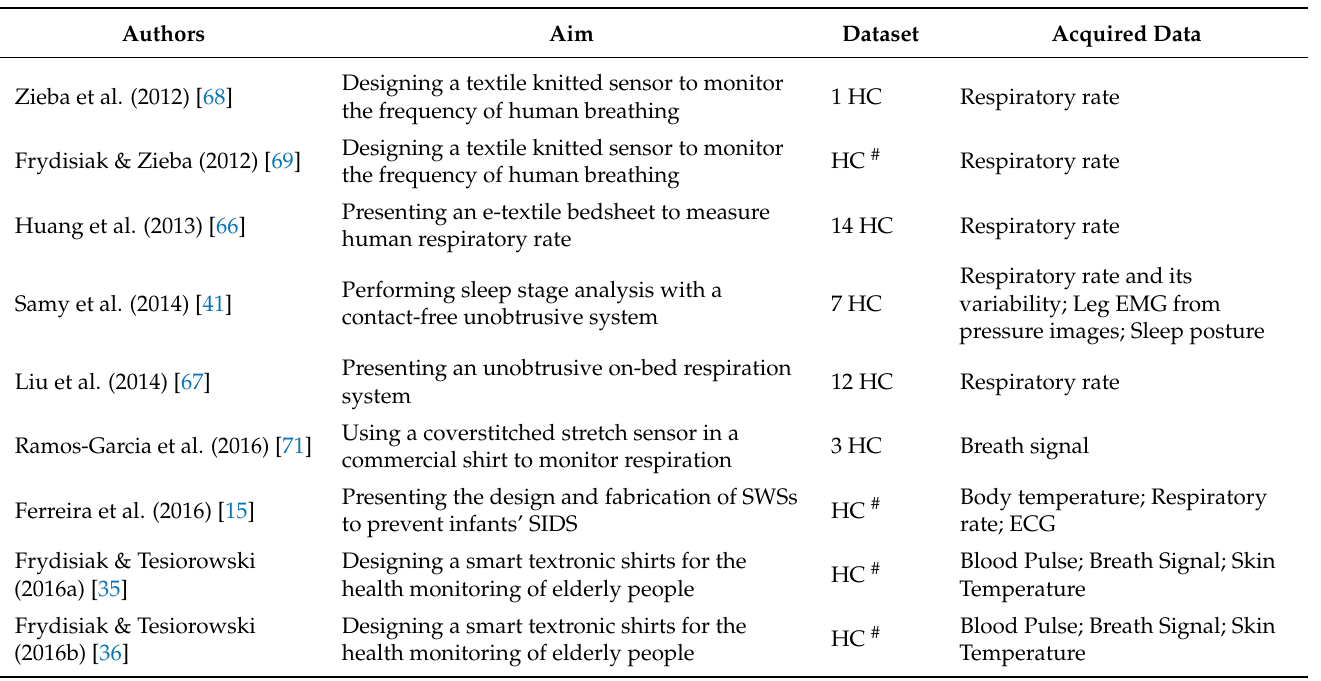
Table 5. Insights regarding literature in in respiratory field: authors, aim, dataset and acquired